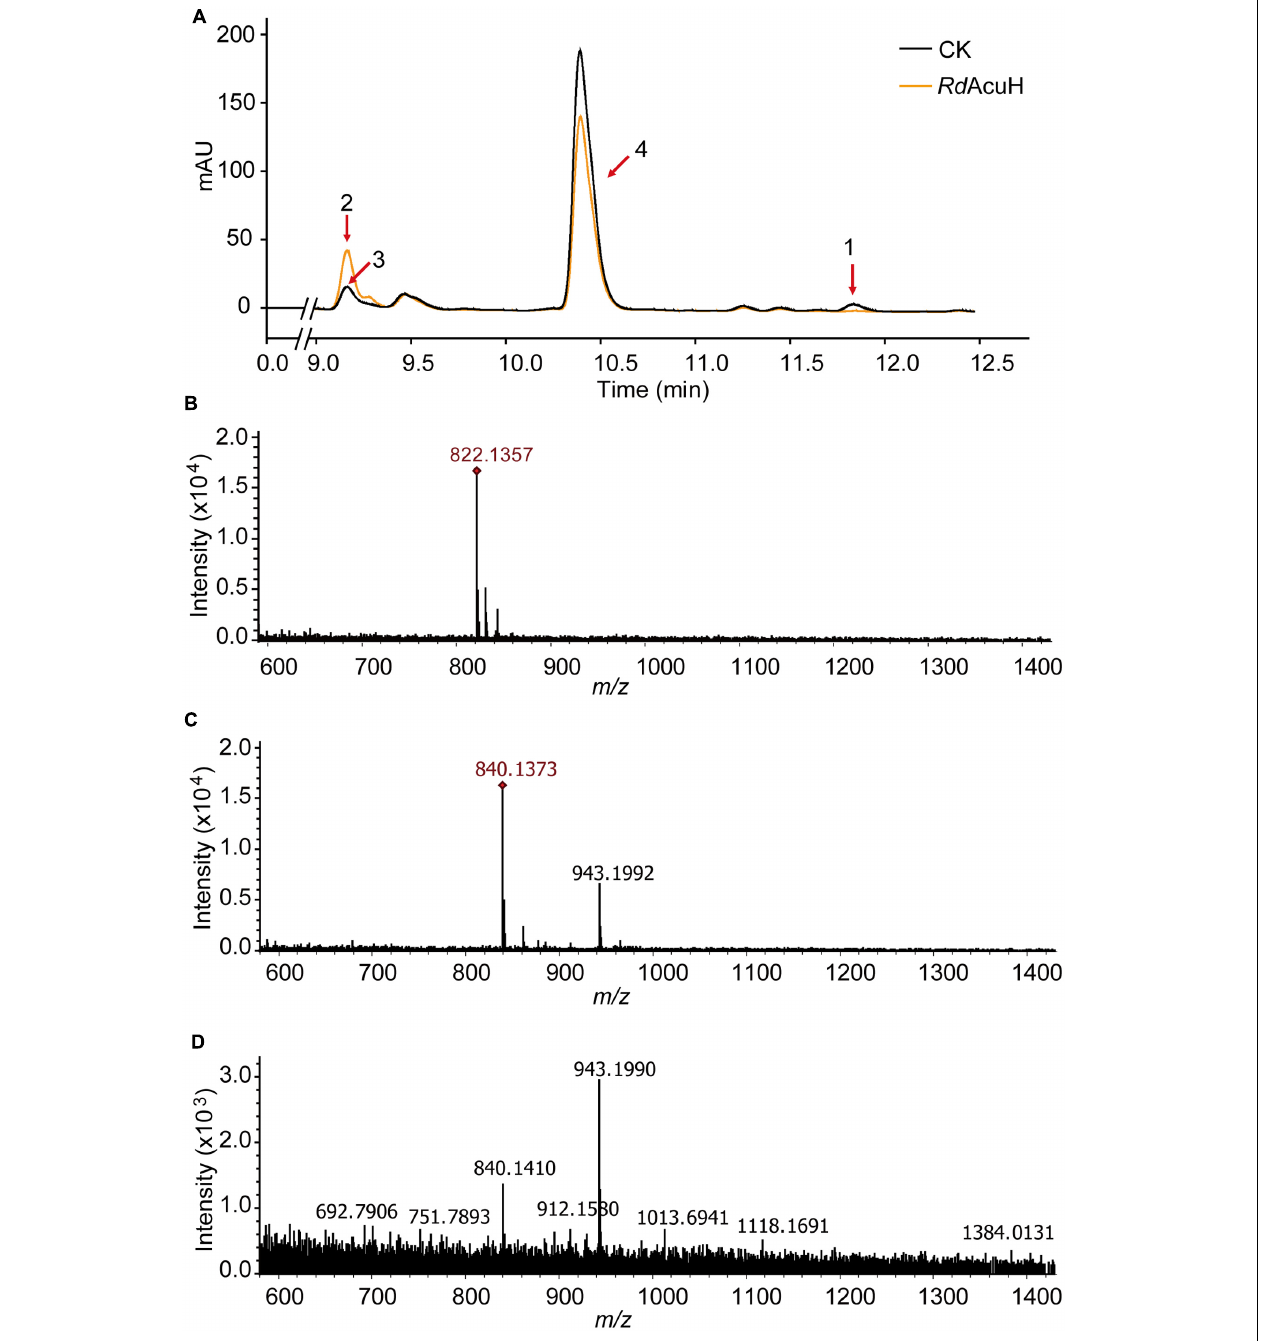
FIGURE 4 | Enzymatic activity detection of Rd AcuH. (A) Enzyme assay of Rd AcuH by HPLC. (B) LC-MS detection of the components of peak 1. The MW of the main compound is 822.1357, which is equal to the MW of acryloyl-CoA, indicating that it is acryloyl-CoA. (C) LC-MS detection of the components of peak 2. The MW of the main compound is 840.1351, which is equal to the MW of 3-HP-CoA, indicating that it is 3-HP-CoA. (D) LC-MS detection of peak 3. Complicate components including a little 3-HP-CoA were